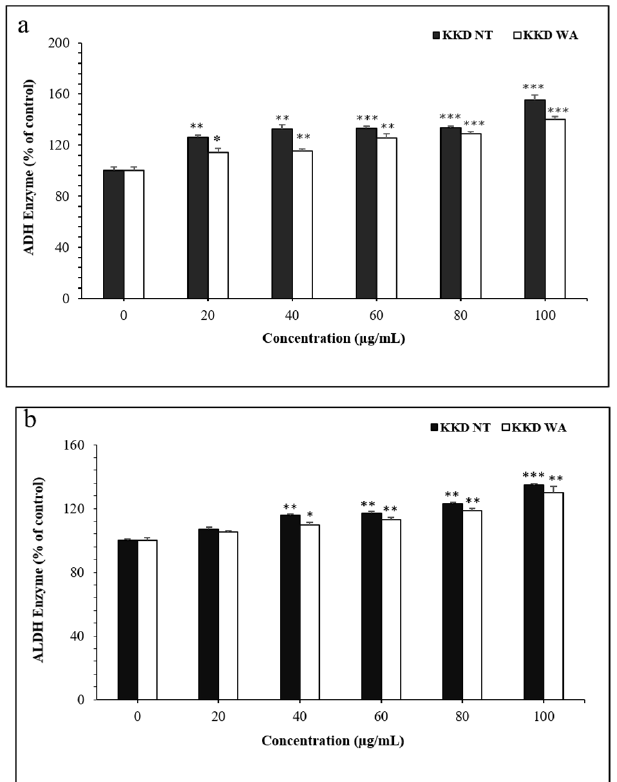
Figure 6. Activities of ADH ( a ) and ALDH ( b ). The activities of both of the enzymes were determined using the methods described in the Materials and Methods section. * p < 0.05, ** p < 0.01, *** p < 0.001 compared to control (CTL).